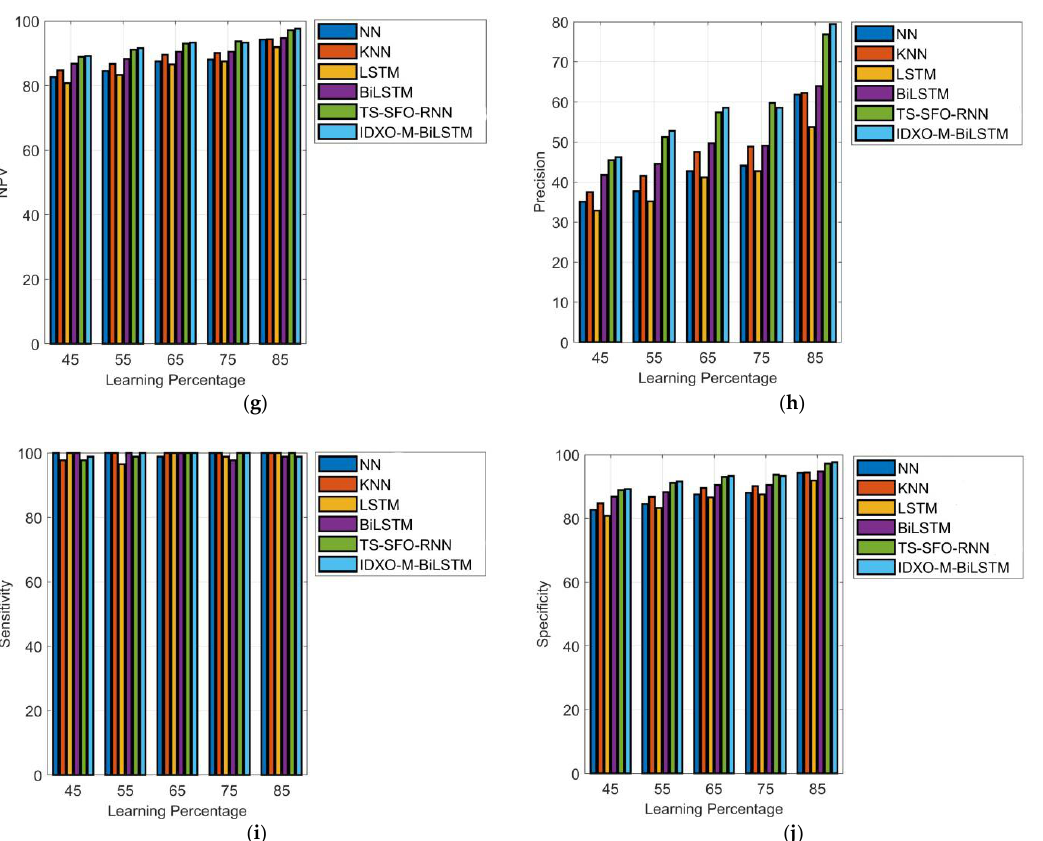
Figure 7. Overall efficacy analysis of the suggested prediction of heart disease model with conven- tional prediction algorithms (NN [49], KNN [50], LSTM [51], BiLSTM [52], TS-SFO-RNN [48]) over ( a ) accuracy, ( b ) F1-score, ( c ) FDR, ( d ) FNR, ( e ) FPR, ( f ) MCC, ( g ) NPV, ( h ) precision, ( i ) sensitivity and ( j ) specificity validation of the initiated model with a baseline algorithm.